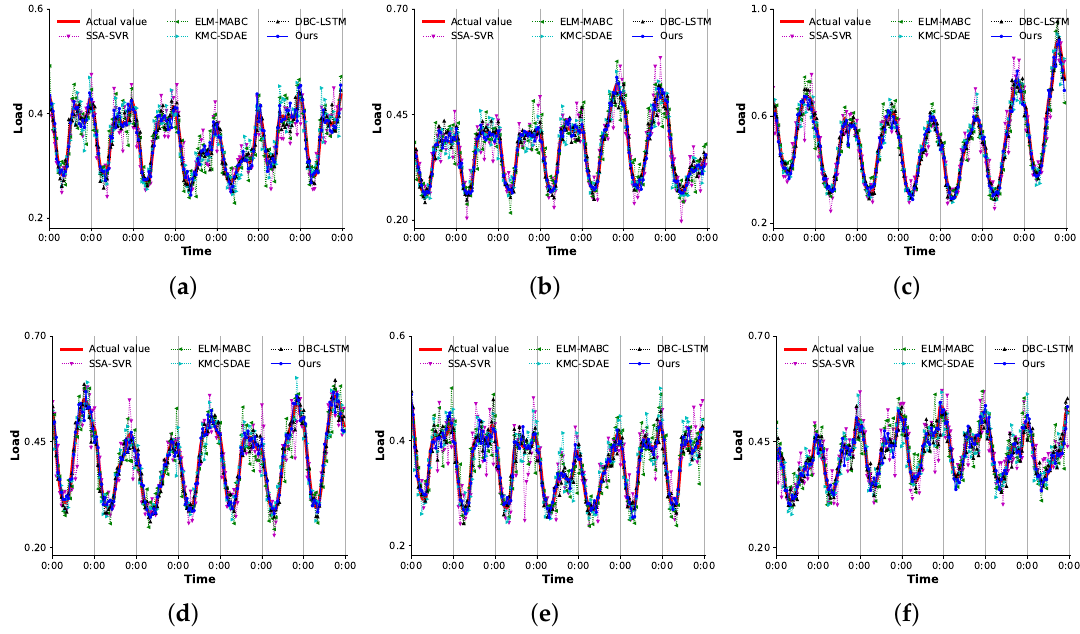
Figure 11. Forecast results for different models and the data from the RECO in ( a ) February, ( b ) April, ( c ) June, ( d ) August, ( e ) October, and ( f ) December